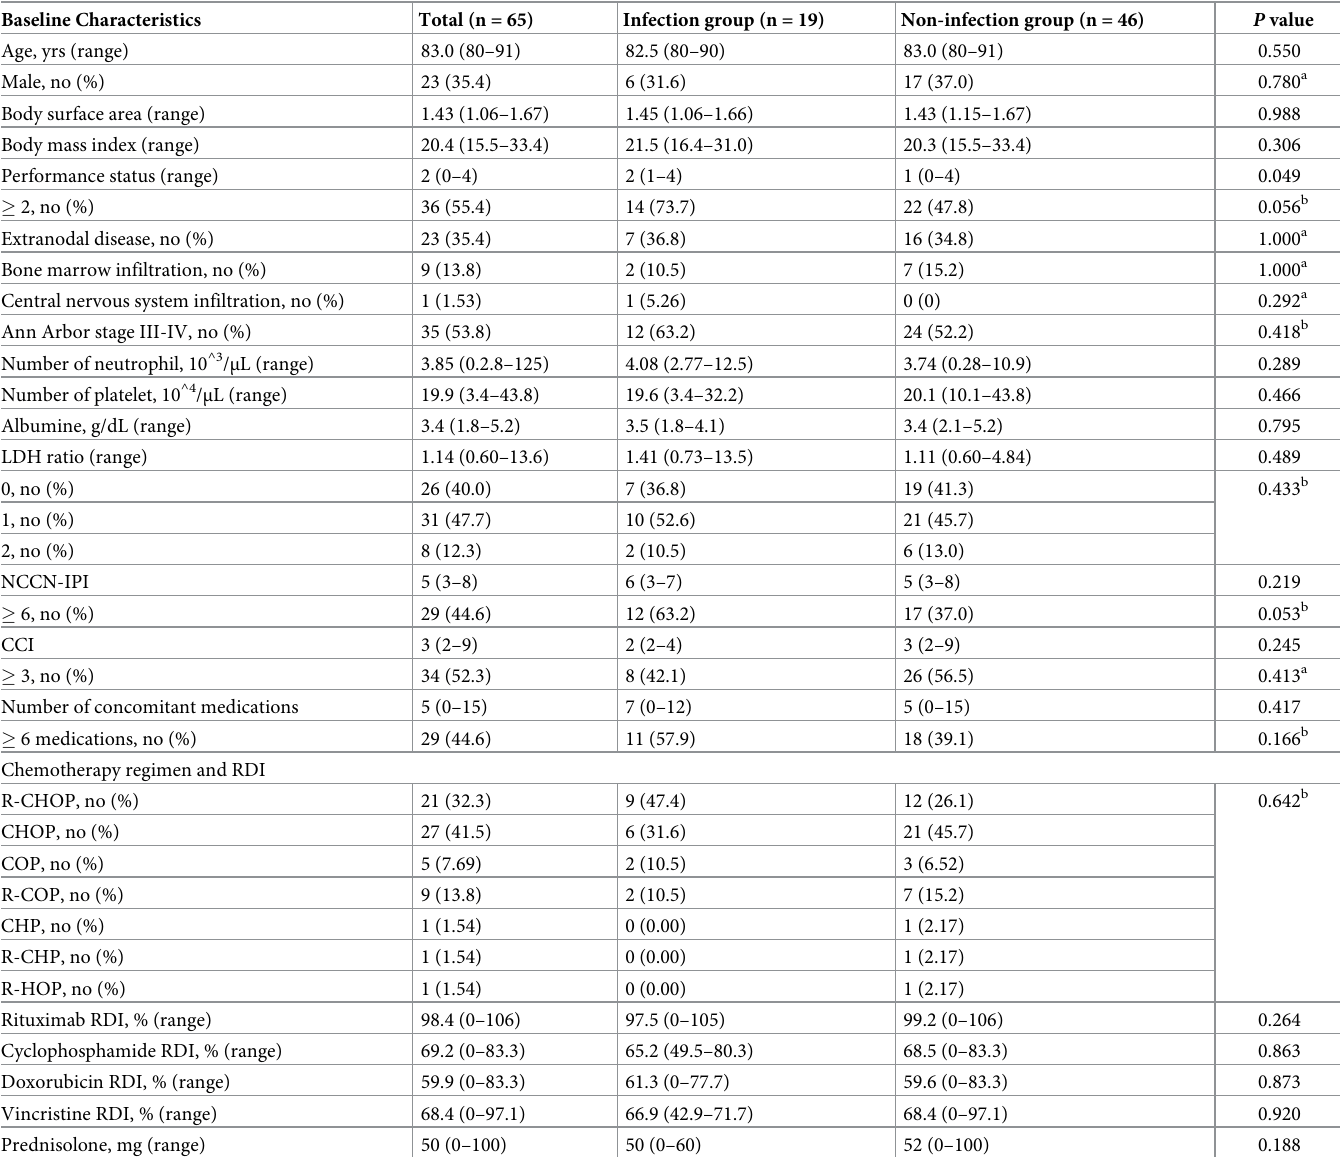
Table 1. Baseline